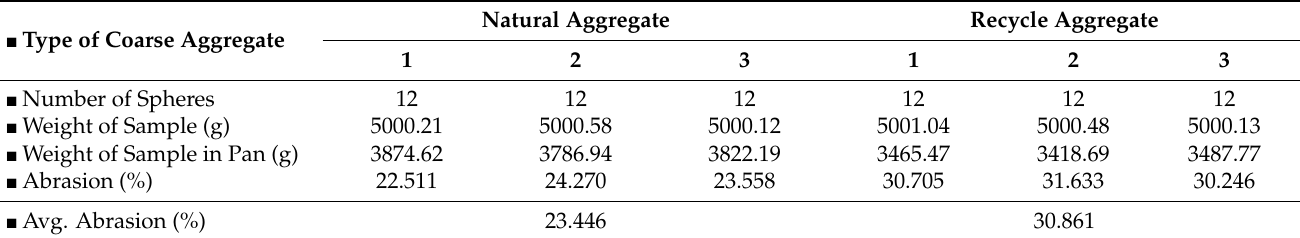
Table 4. Unit weight and water absorption characteristics of natural and recycled